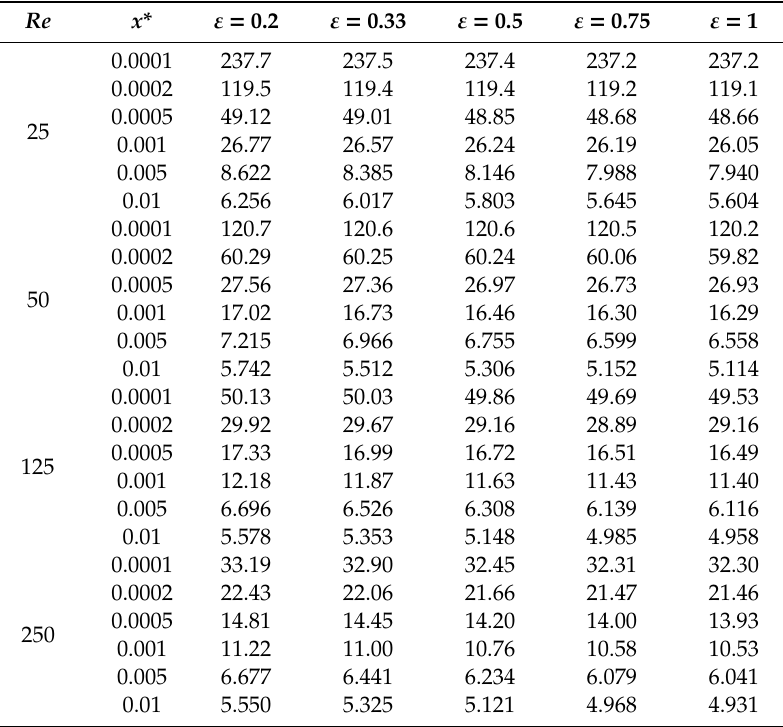
Table 2. A numerical sample of data for Nu ( x ).